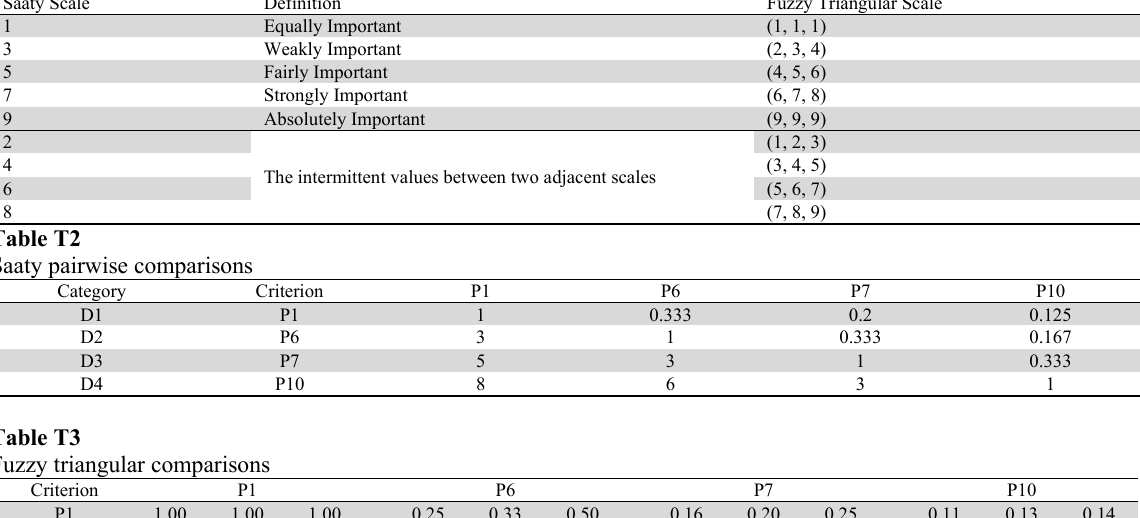
Fuzzy pairwise comparison (Ayhan, 2013) Saaty Scale